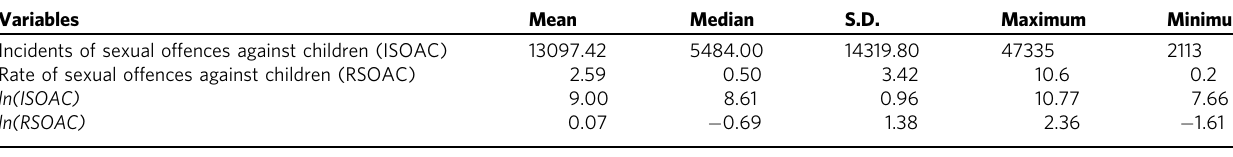
Table 2 Descriptive statistics of sexual offences against children in India.